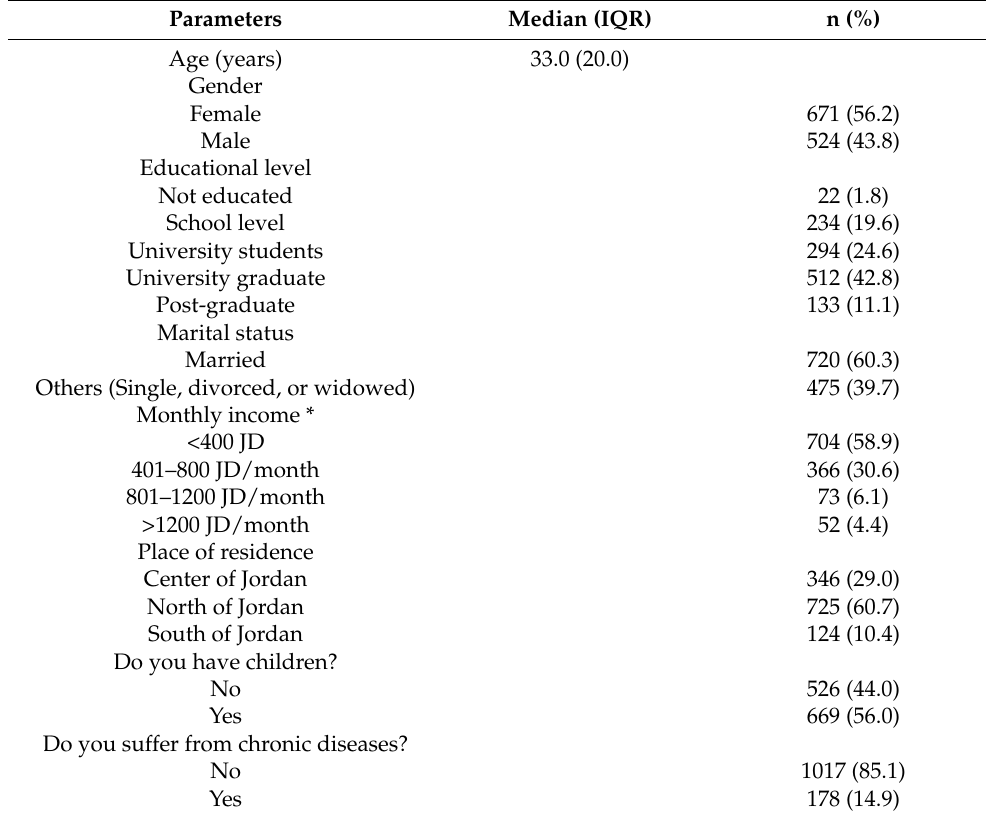
Table 1. Sociodemographic characteristics of the study participants (n =